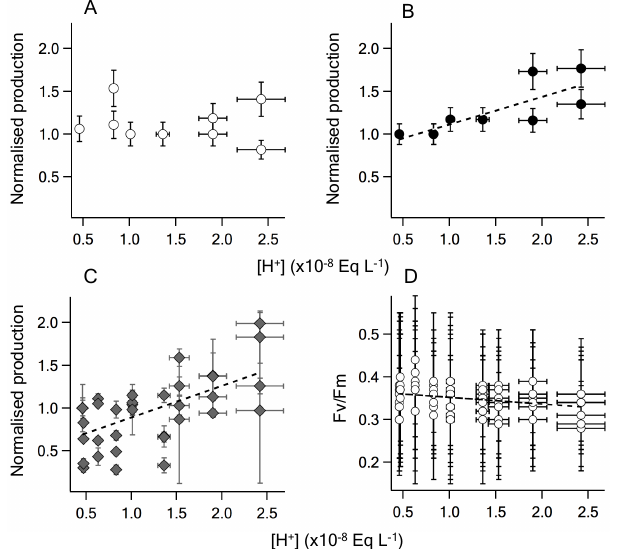
Fig. 5. Phytoplankton production in relation to [H + ] during PII for: (A) µDMSP, measured in water from 3 mesocosms on 3 dates. Rates were normalised to the rate measured at the lowest [H + ] con- centration on each date. Error bars show the estimated SD taking into account the precision in DMSPp concentrations and the ratio of mass 64 − DMS; and SD of [H + ]; and (B) normalised DMSPt production. Coefficients of the linear regression ( y = a + bx ) are: a = 0.77( ± 0.16SE); b = 0 . 35 ( ± 0.10SE) ( P = 0 . 011) ( n = 9). (C) inorganic carbon fixation measured in water from nine mesocosms on four dates during PII. Rates are normalised to the rate mea- sured in mesocosm 3, (initially at ambient [H + ]). Regression coeffi- cients are: a = 0.51 ( ± 0.12 SE); b = 0 . 39 ( ± 0.09SE) ( P = 0 . 0001) ( n = 36). Note values measured in mesocosm 7, also at close to ambient [H + ], were consistently lower than in mesocosm 3. Er- ror bars show the SD of carbon incorporation and of [H + ]. (D) maximum potential quantum efficiency of photosystem II ( F v / F m ) . The bars represent the SD of individual measurements accounting for uncertainty in estimates of F o and F m . Regression coefficients are: a = 0 . 68 ( ± 0.01SE); b = − 0 . 016 ( ± 0.005SE) ( P = 0 . 004) ( n = 72).